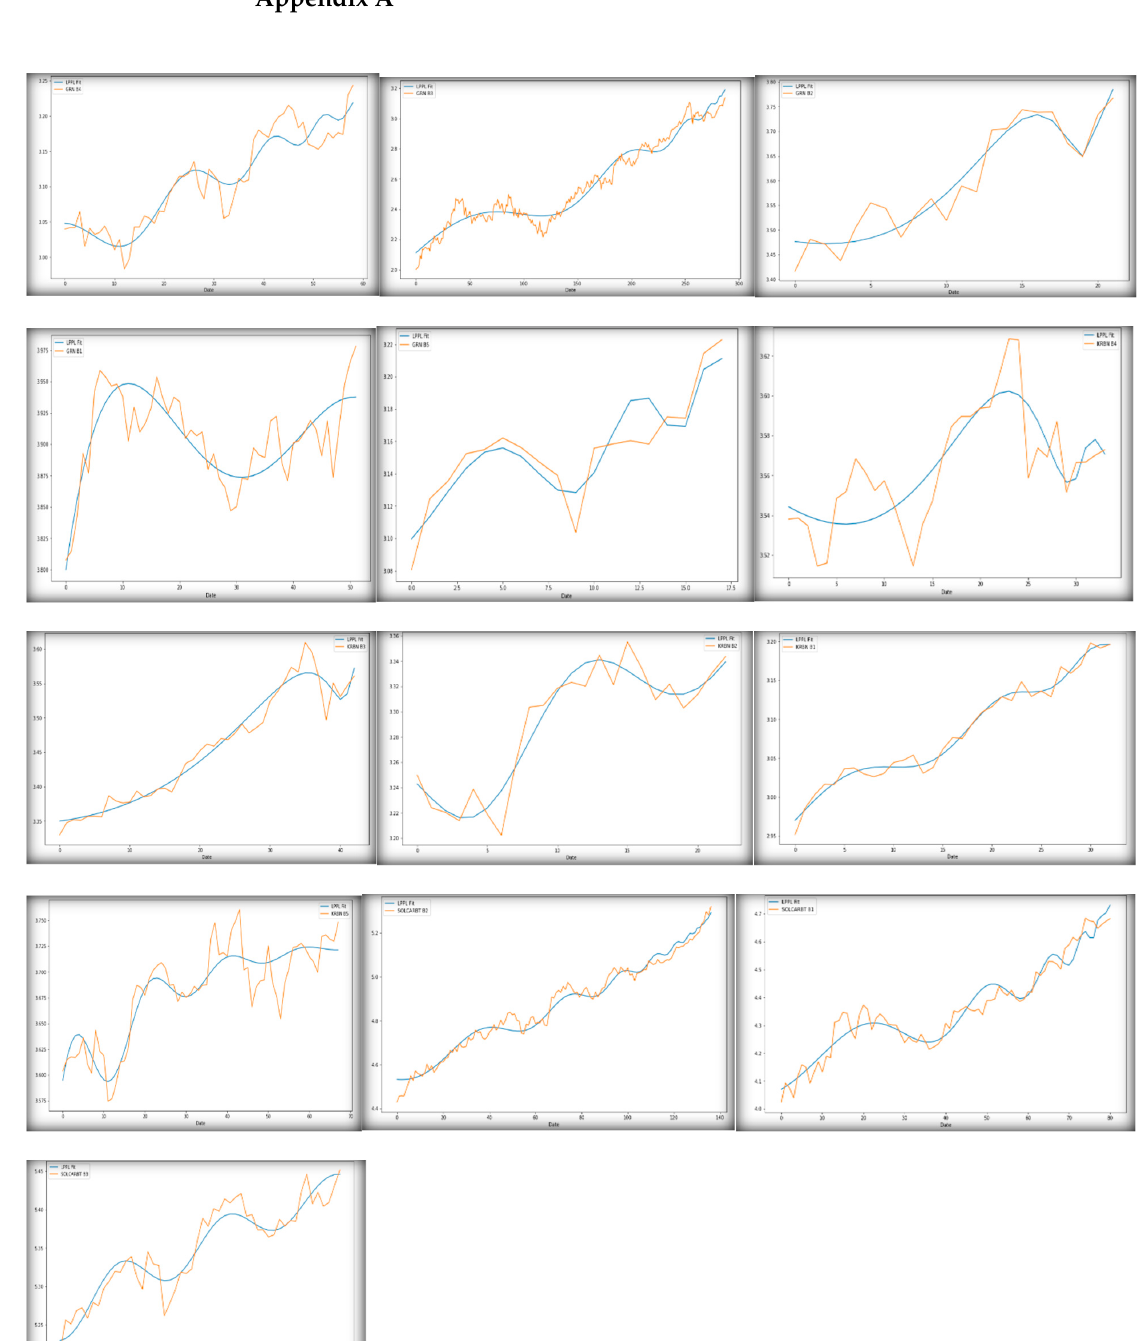
Figure A1. Proof of LPPL Signatures. The Bubbles in KRBN, GRN ETFs, and SOLCARBT Index Standing as Proxy of Global Carbon Credit Trading, within the COVID-19 Out-Break Period (10 September 2019 to 11 November 2021).